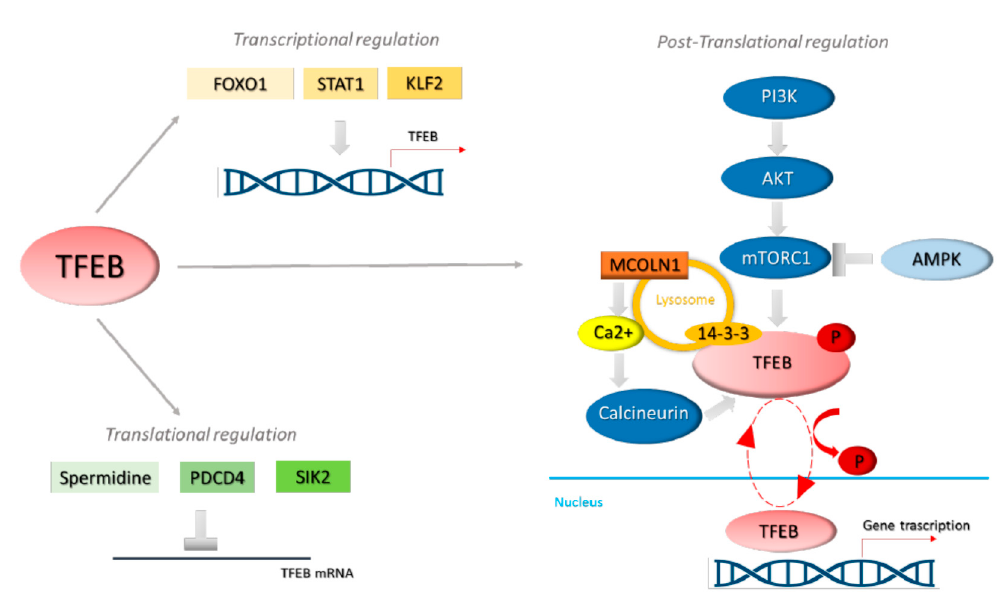
Figure 2. Control of TFEB transcription, translation, sub-cellular localisation, and activity. TFEB transcription level is controlled by the binding of its promoter by Forkhead box O1 (FOXO1), signal transducer and activator of transcription 1 (STAT1), and by Krüppel-like factor 2 (KLF2) [11–16]. TFEB translation is also regulated by programmed cell death 4 protein (PDCD4) and spermidine [11–16]. TFEB sub-cellular localisation and activity is under the control of phosphoryla- tion level. In particular, under nutrient-rich conditions mTORC1 is activated via the PI3-K/Akt pathway. TFEB is phos- phorylated by mTORC1 and retained in the cytoplasm on the lysosomal surface via the 14-3-3 proteins binding. In stress conditions, mTORC1 is inactivated, also via AMPK, and TFEB, no longer phosphorylated, is free to translocate to the nucleus. Moreover, in these conditions, Ca 2+ is released from lysosome and induces calcineurin activation that dephosphorylates TFEB, supporting its nuclear translocation. TFEB cellular localisation is mediated by the phosphoryla- tion in Ser sites. TFEB cytosolic retention is supported by its phosphorylation at (i) Ser122, Ser211, and Ser142 by mTOR; (ii) Ser134 and Ser138 by GSK3; and (iii) Ser142 by ERK-1/2. TFEB nuclear export is induced by its phosphorylation at (i) Ser 138 by GSK3; (ii) Ser142 by CDK4 or CDK6 [15,16,19].